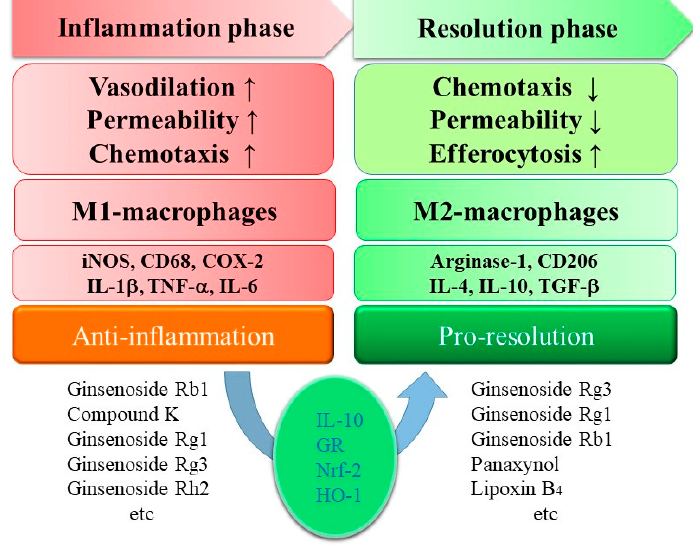
Figure 2. Summarized effects of ginsenosides on M1- and M2-polarized macrophages during inflammatory and resolving phases.